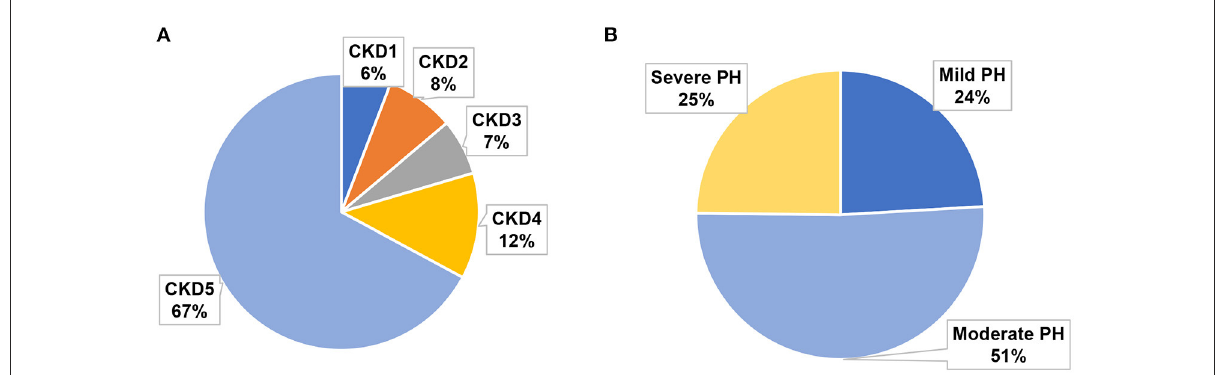
FIGURE1 Proportion of different CKD stages and PH severities in the study cohort. (A) Proportions of CKD 1–5. (B) Proportions of mild, moderate, and severe PH.